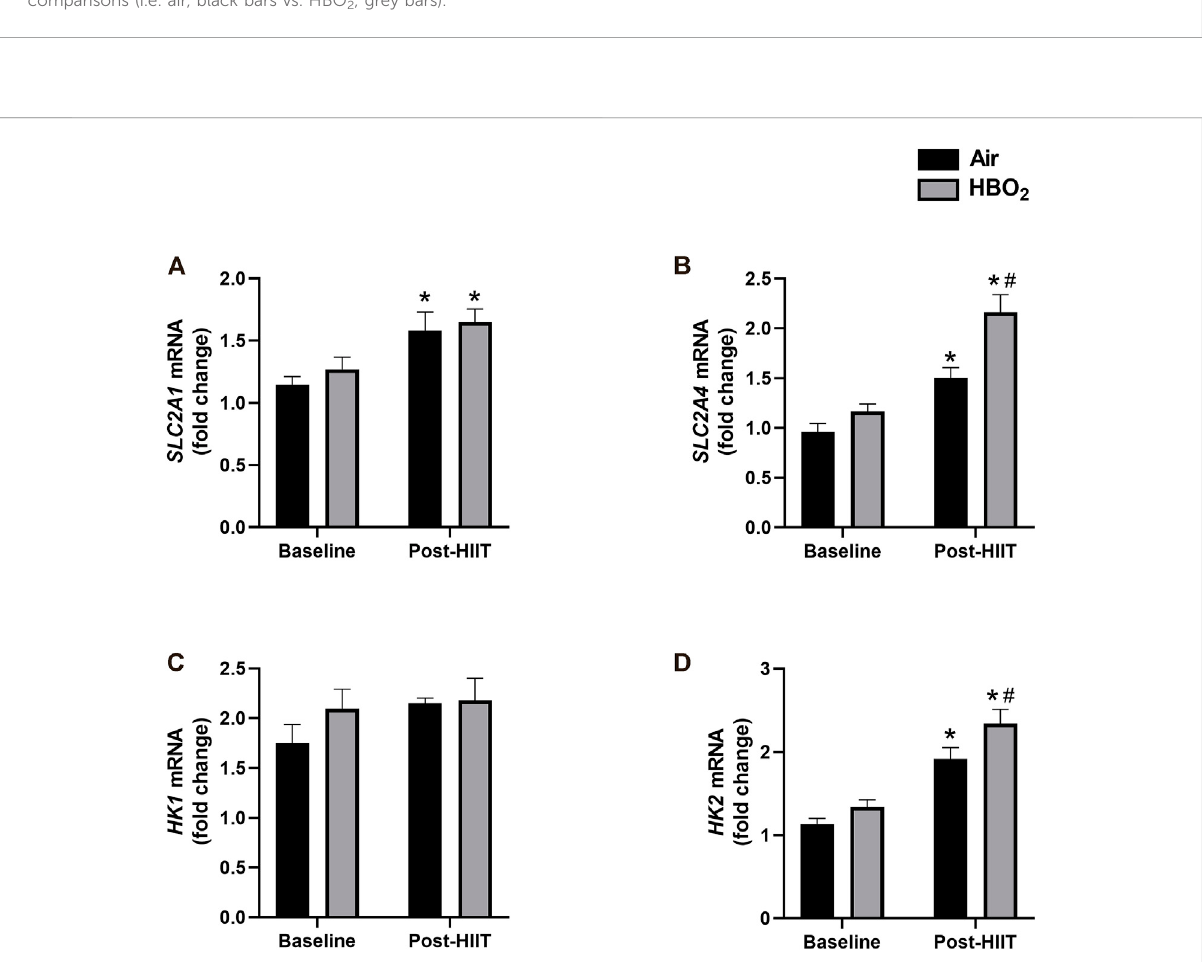
FIGURE 6 Glucose-related gene expression. mRNA levels of the following genes were measured by quantitative PCR: (A) SLC2A1 , Solute carrier family 2, facilitated glucose transporter member 1; (B) SLC2A4 , Solute carrier family 2, facilitated glucose transporter member 4; (C) HK1 , hexokinase-1; and (D) HK2 , hexokinase-2. Reference mRNA was 18S and shown as fold-change. Statistical analysis was 2-way ANOVA with repeated measures and Fisher ’ s LSD post-hoc test. * p < 0.05 shows signi fi cant within group comparison (i.e. baseline vs. post-HITT) and # p < 0.05 shows signi fi cant between group comparisons (i.e. air, black bars vs. HBO2, grey